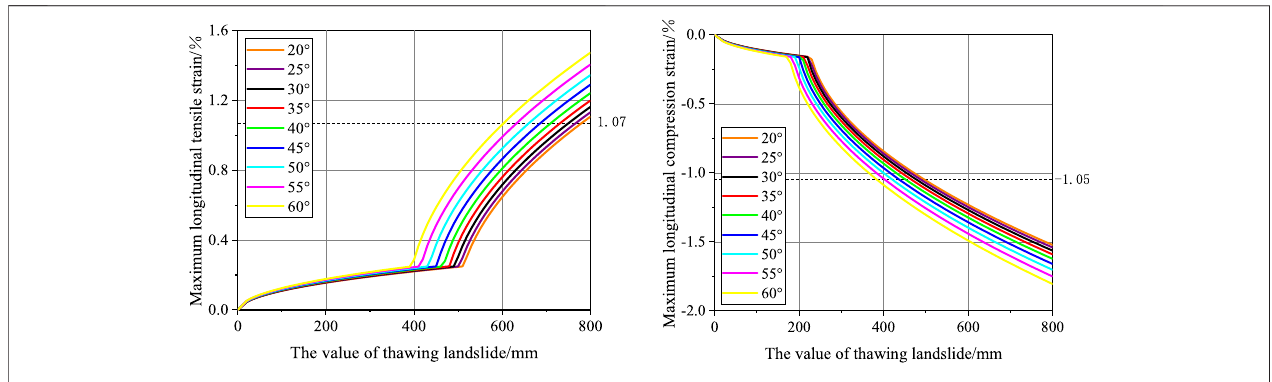
FIGURE 16 | In fl uence of slope angle on the maximum longitudinal